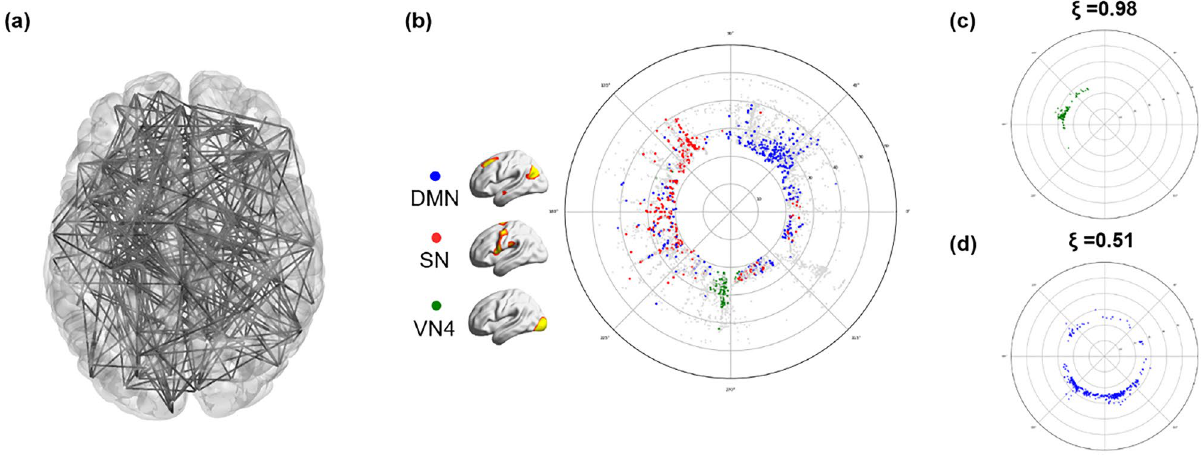
Figure 1. Hyperbolic disc embedding and angular coherence of the voxels on the disc. ( a ) A brain network with 500 random nodes was displayed using 3-dimensional MNI coordinates projected on a 2-dimensional brain space. This visualization provides intricate edges and nodes that are not easily discernible. ( b ) Hyperbolic disc embedding provides easy-to-recognize visualization of the voxels on the hyperbolic disc. In this hyperbolic disc, 5937 voxels were used, which shows the intervoxel relationships between voxels in an unoverlapped way with 10 times more voxels than the one in ( a ). Specifically, the brain was resampled into 5937 6 × 6 × 6 mm 3 voxels, which were assigned as voxels of subnetworks belonging to independent components (ICs) 34 . The hyperbolic distance between two voxels on this hyperbolic disc is equivalent to the correlation proximity between these voxels in Euclidean space. The radial coordinate responds to the degree of the voxel, i.e., the hub voxel is near the center of the disc, and the angular coordinate responds to the similarity of voxels 32 . As an example, voxels from the independent component (IC) subnetworks are presented in different colors. The voxels from the salience network (SN) (red) are more widely distributed on angular coordinates than the default mode network (DMN) (blue) or visual network 4 (VN4) (green). ( c ) The angular coherence quantifies the degree of aggregation of a group of voxels based on coordinates. It ranges from 0 to 1, and a higher value indicates compact gathering with smaller differences in angles between voxels in the group. Widely spread voxels have a lower value of angular coherence. The angular coherences of voxels comprising ( c ) VN4 (ξ = 0.98), ( c,d ) DMN (ξ = 0.51) are